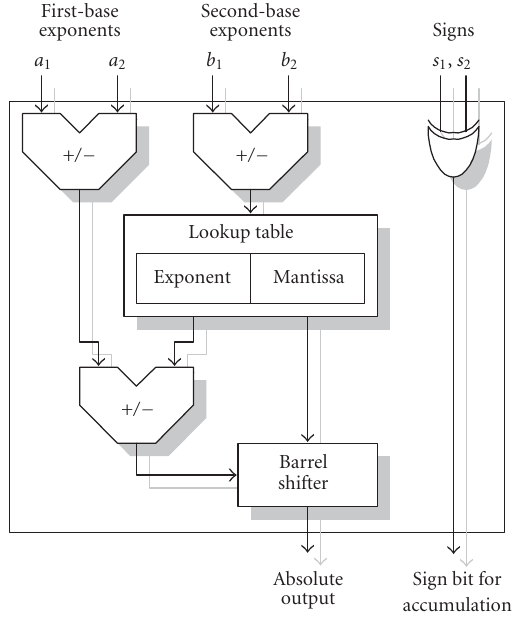
Figure 10: Dual one-bit sign 2DLNS processor.